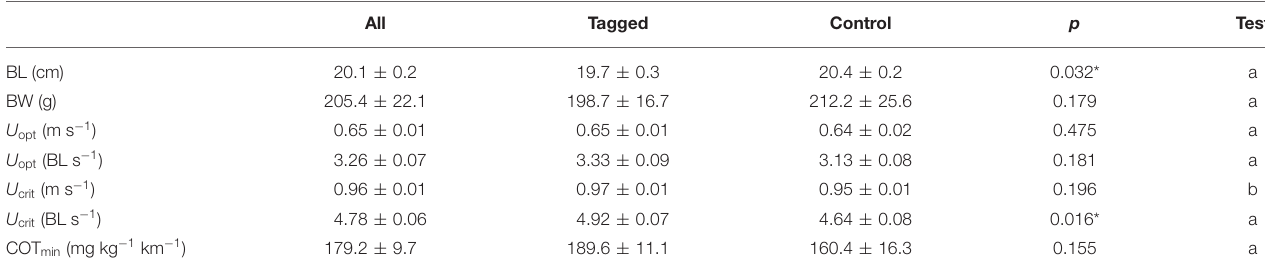
TABLE 1 | Mean values ( ± SE) of body length (BL), body weight (BW), optimal swimming speed ( U opt ), critical swimming speed ( U crit ), and minimum oxygen cost of transport (COT min ) for tagged and control seabream in the swim-tunnels, and significance of differences between tagged ( N = 10) and non-tagged fish ( N = 10) for all parameters (ANOVA, significance level: p < 0.05, indicated with an asterisk: * ). All